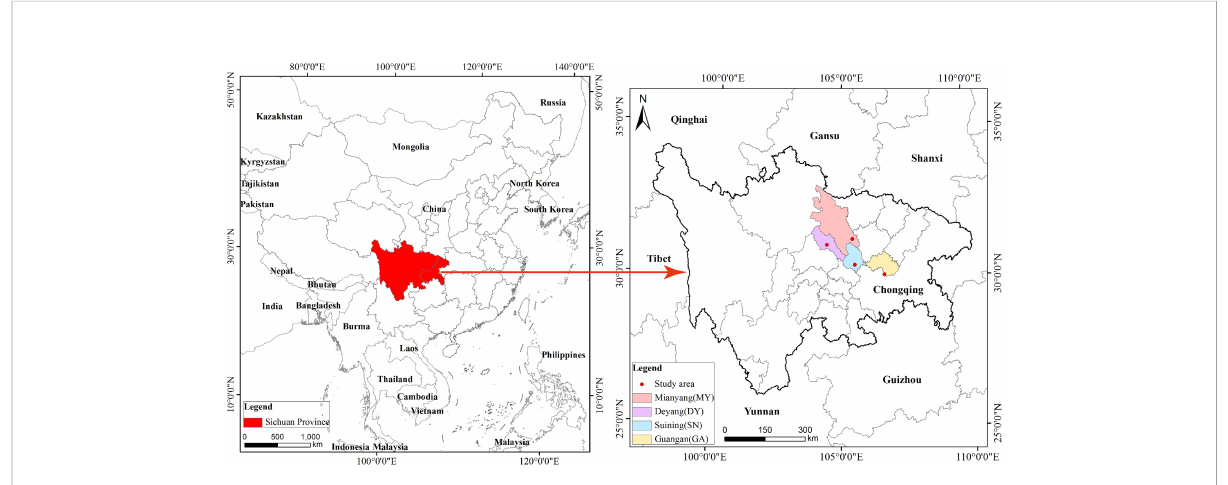
FIGURE 1 Location of the four research sites. Four study area in Sichuan province Mianyang (MY), Deyang (DY), Suining (SN), Guangan